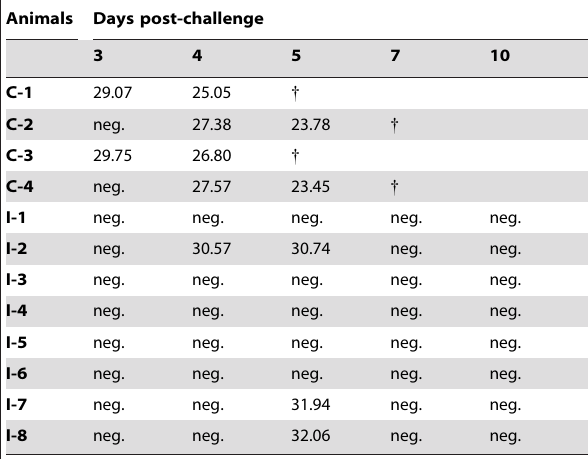
Table 1. Detection of BTV-4 in blood of immunized and nonimmunized IFNAR ( 2 / 2 ) mice after challenge with BTV-4 by